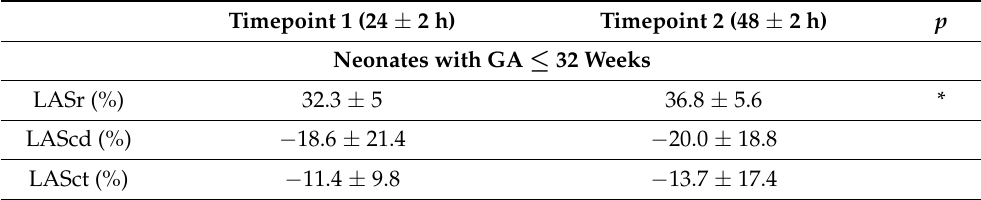
Table 5. LAS reference ranges at 24 and 48 h in the second cohort of